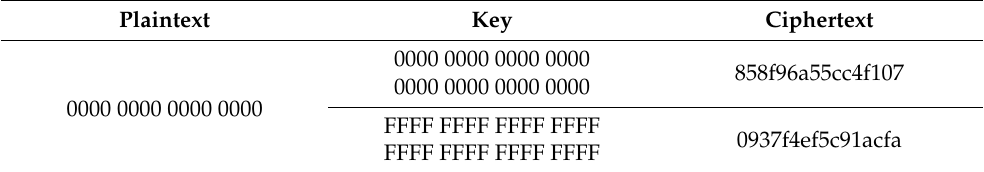
Table A2. Test vector (for 128-bit